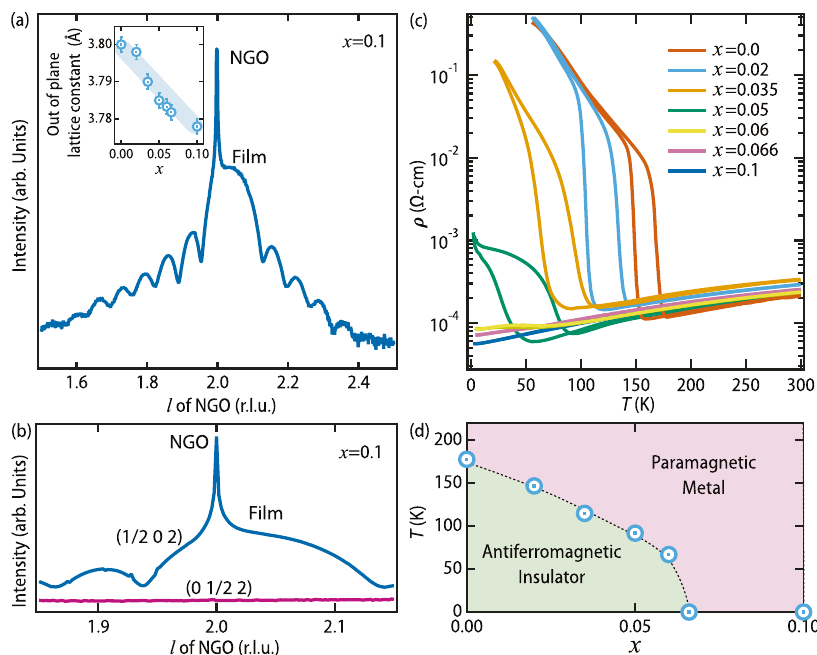
Fig. 1 Structural characterization and electronic properties. a l scan using X-ray diffraction of the x = 0.1 fi lm through the (0 0 2) pc (pc denote pseudo- cubic setting) truncation rods. The change in the out-of-plane lattice constant with hole doping has been shown in the inset. The error bar is de fi ned according to the step size of the l scan. The shaded region is a guide to the eye. b l scan of x = 0.1 sample around the (0 1/2 2) pc and (1/2 0 2) pc truncation rod at 300 K. c Temperature dependence of resistivity of Ca-doped NdNiO 3 fi lms. The data for x = 0 fi lm has been adapted from ref. 44 . d Phase diagram of Nd 1 − x Ca x NiO 3 thin fi lms. T MIT (metal to insulator transition temperature) ~ T N (paramagnetic to E 0 -AFM transition temperature) in heating run have been plotted as a function of x (hole doping). See Supplementary Note 3 for the details about the extraction of T N from the transport